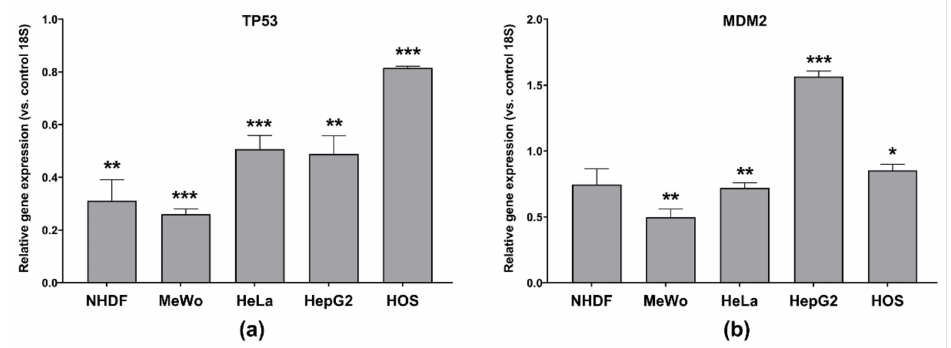
Figure 10. ( a ) TP53 gene expression; ( b ) MDM2 gene expression in normal dermal fibroblasts (NHDF), malignant melanoma (MeWo), adenocarcinoma (HeLa), hepatocellular carcinoma (HepG2) and osteosarcoma (HOS) cells treated with cell line-specific IC 50 of CBD-enriched hemp oil for 48 h. Control cells were incubated with complete cell culture medium. Experiments were done in triplicate, obtained data were expressed as mean 2 − ∆∆ Cq values (vs. 18S of control cells) ± standard error of the mean. * p < 0.05, ** p < 0.01, *** p < 0.001 vs. control cells (TP53: NHDF p = 0.001014, MeWo p = 0.000003, HeLa p = 0.000669, HepG2 p = 0.001736, HOS p = 0.000011; MDM2: NHDF p = 0.065319, MeWo p = 0.001181, HeLa p = 0.002125, HepG2 p = 0.000358, HOS p =